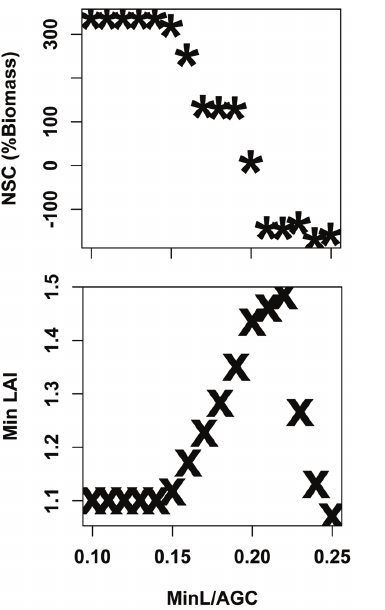
Figure 6. Estimates of a) minimum NSC and b) minimum LAI over 1992 – 2007 simulation period for high elevation stands. Graphs show variation in minimum NSC and LAI across variation in MinL/AGC with NSC/NPP set equal to 0.25.